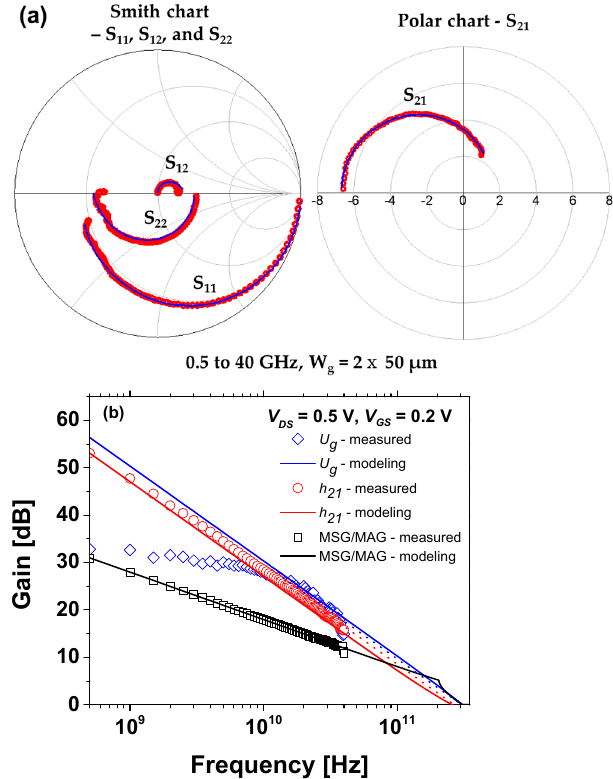
Figure 4. ( a ) Comparison of small-signal modeling and measured S-parameters at V DS = 0.5 V and V GS = 0.2 V. A Smith chart of S 11 , S 12 , and S 22 (left) and a polar chart of S 12 (right). ( b ) Measured (symbols) and modeled (solid lines) of RF gains-Maximum oscillation frequency ( f max ), maximum stable gain (MSG)/maximum available gain (MAG), and unity current gain cutoff frequency ( f T ) of the mHEMTs at V DS = 0.5 V and V GS = 0.2 V. Table 1. Extracted intrinsic small-signal parameters.